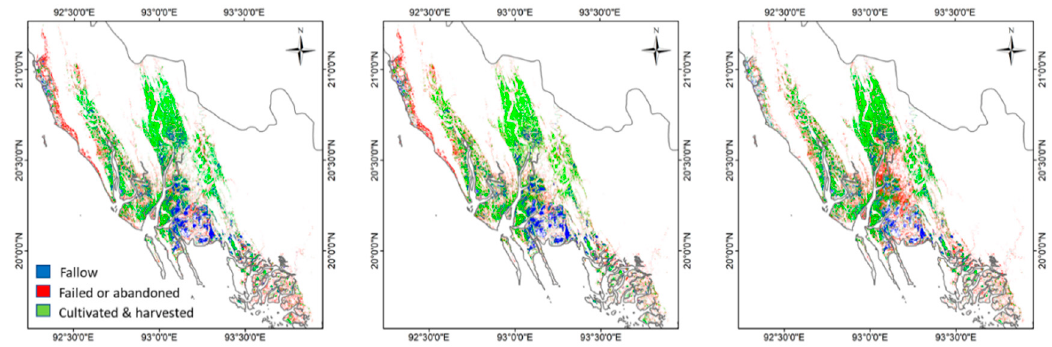
Figure 8. Assessment of fallow, failed or abandoned, and cultivated rice paddies across Rakhine for 2016, 2017, and 2018 using time series Sentinel-1 showed nearly one-third of paddies are classified as failed or abandoned and anecdotally were spatially associated with reports of conflict and qualitatively affiliated with burnt area signals and limited field reports. . a ffi liated with burnt area signals and limited field reports.